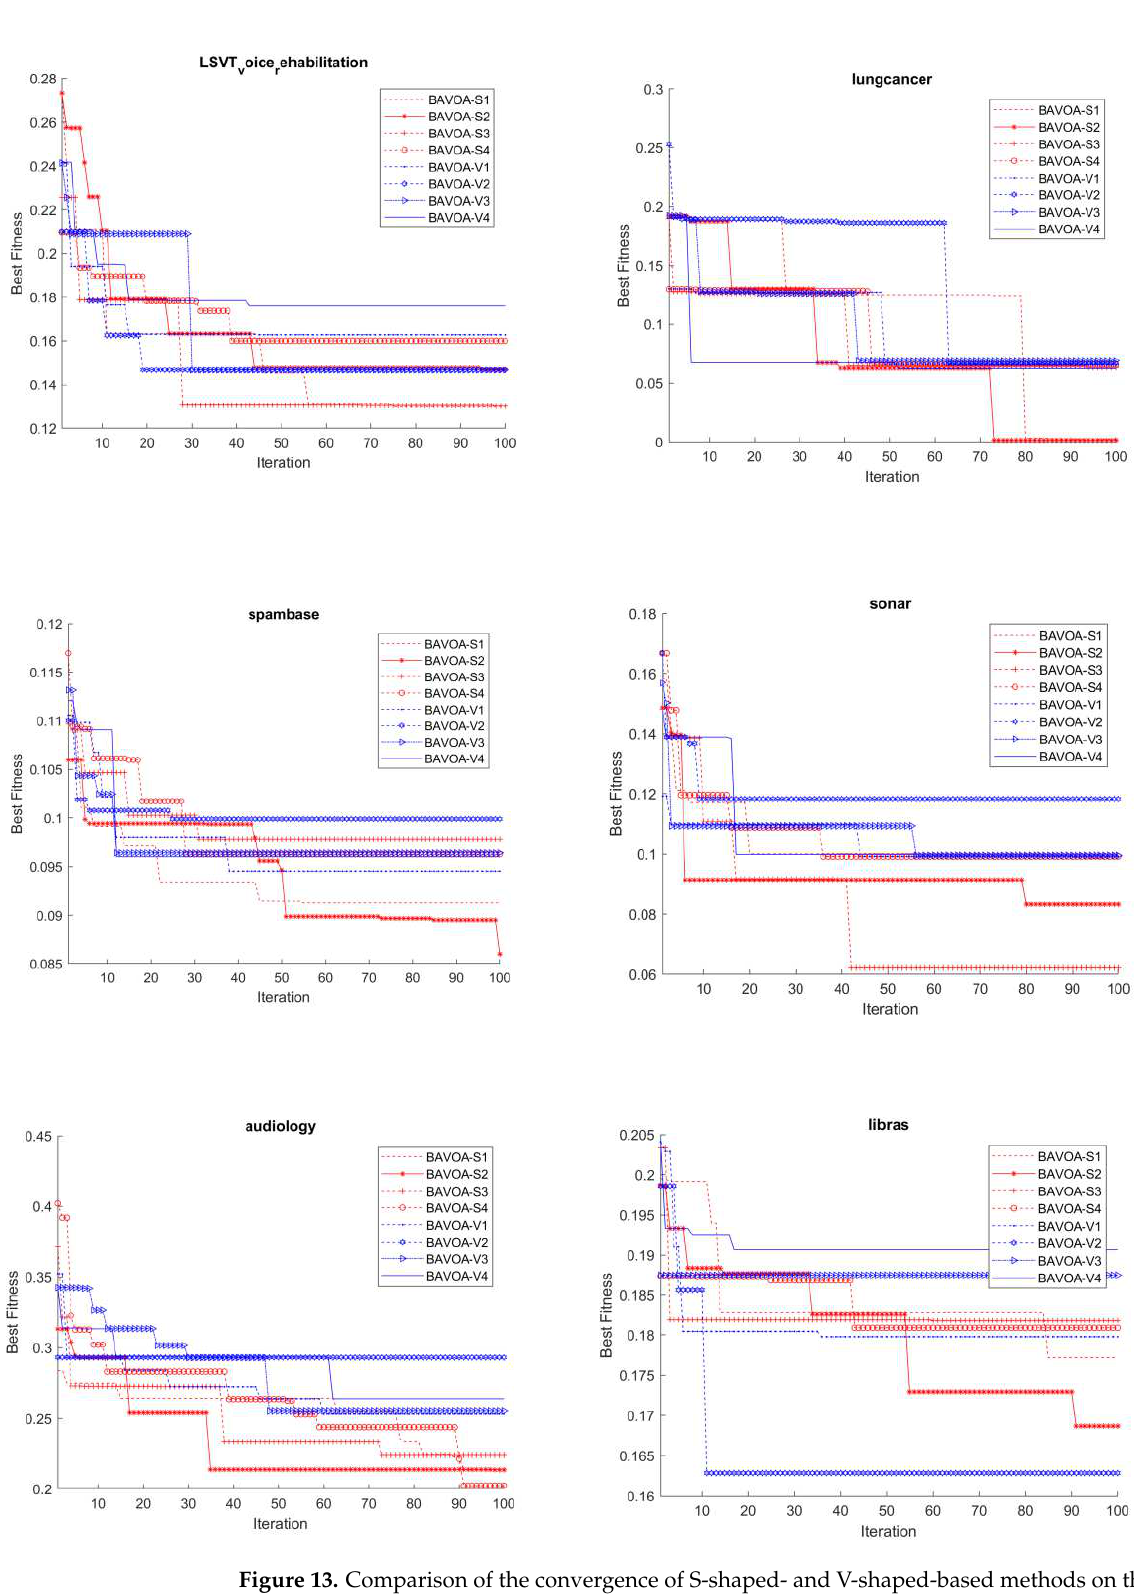
Figure 13. Comparison of the convergence of S-shaped- and V-shaped-based methods on the fourth six data sets .